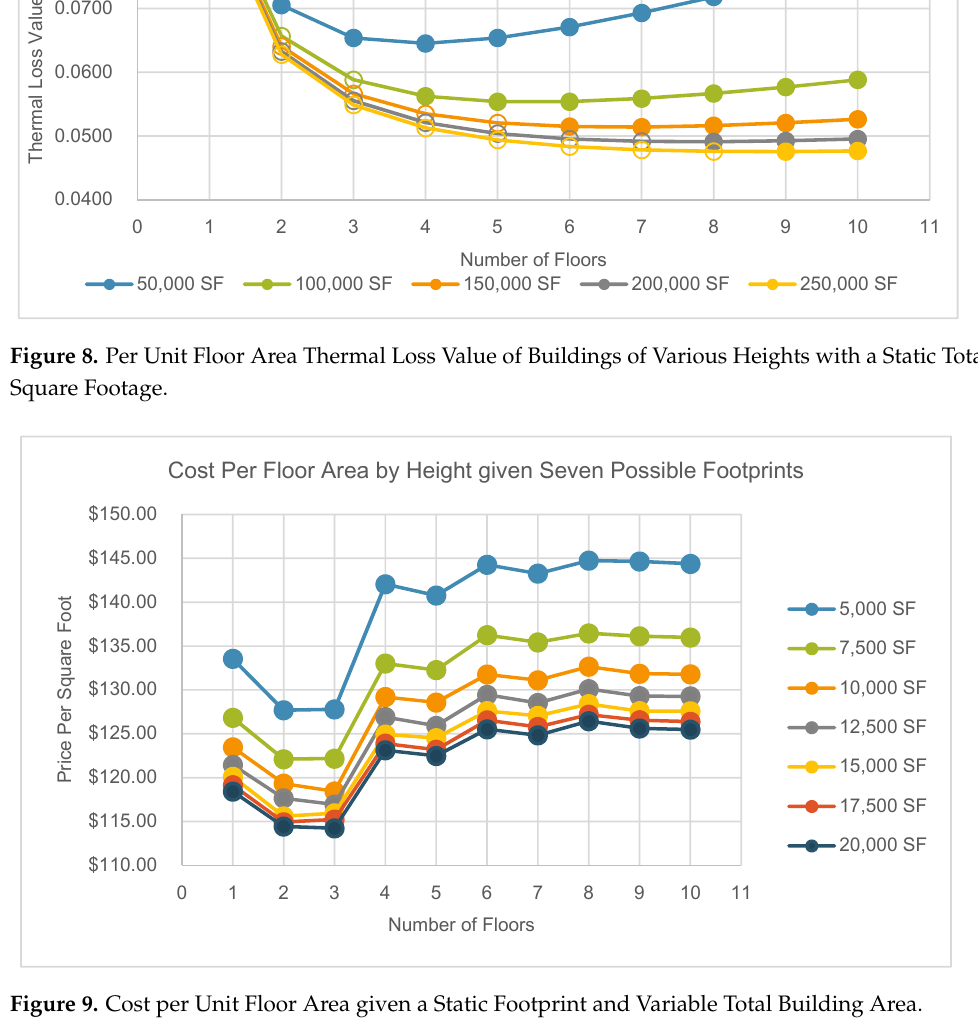
Cost per floor area by height reflects costs when operating with a constant floor plate.